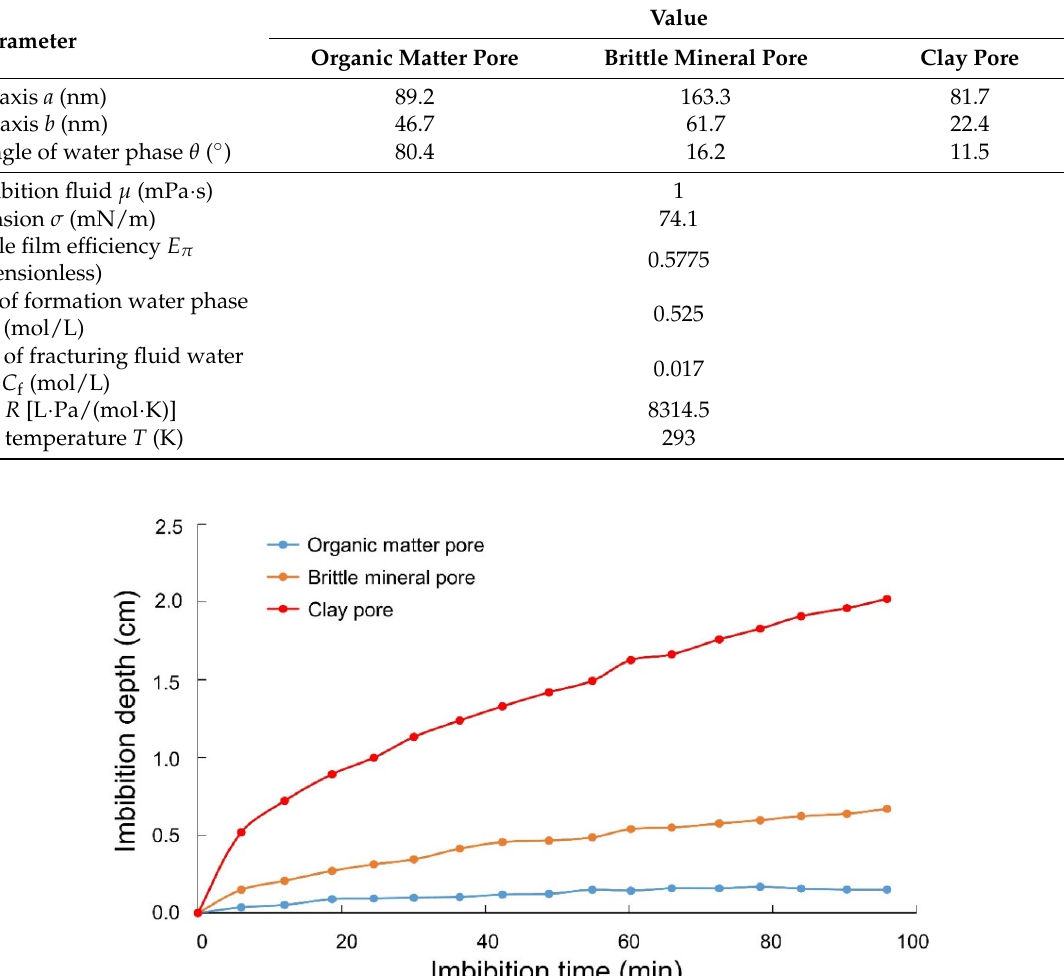
Table 3. Basic parameters of shale samples and testing fluid.